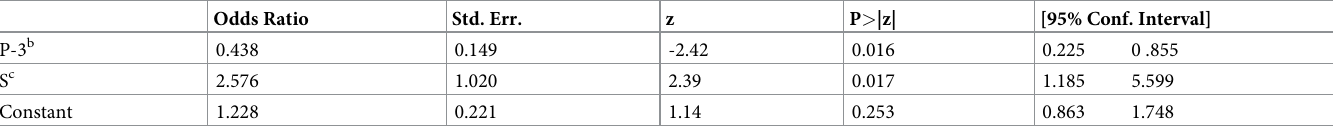
Table 2. Results of logistic regression a